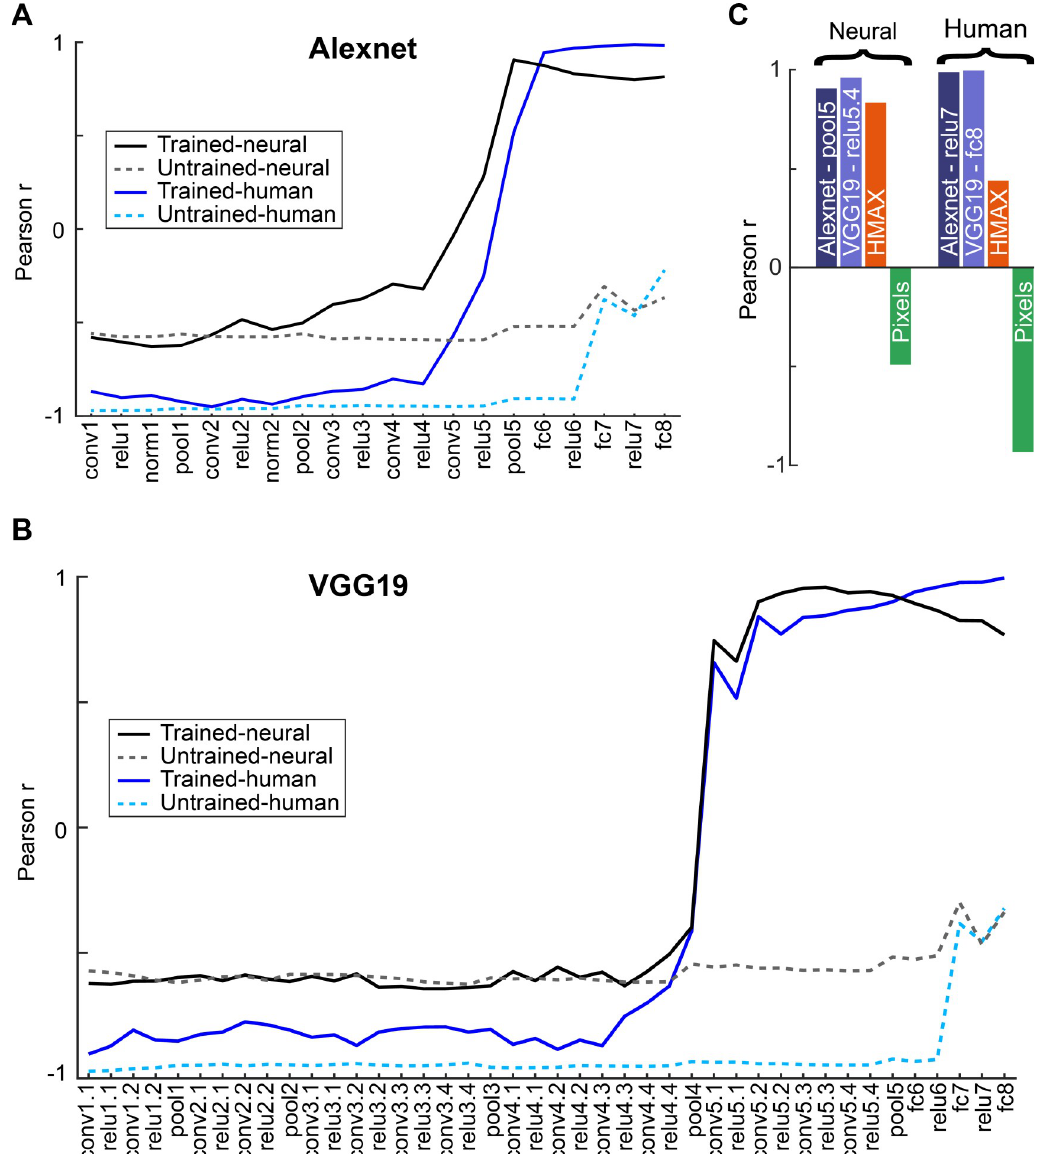
Fig 10. Correspondence between model dissimilarities and biological dissimilarities (IT responses and human judgement- based dissimilarities) for the shape groups. (A, B). Gray curves show the Pearson correlation coefficients between the mean neural distances and the mean distances of the CNN layers (n = 6 mean distances per layer). Blue curves show the Pearson correlation coefficients of the CNN layer distances and the distances based on human judgements. Data for trained and untrained CNNs are plotted with full and dashed lines, respectively. Nomenclature of CNN layers as in Fig 2. Results for all two models (Alexnet and VGG-19) are displayed in the subplots (A, B). (C) Neural: Pearson correlation coefficient between the mean IT distances and the mean distances of the peak Alexnet layer, peak VGG-19 layer, the mean HMAX C2 layer distances, and mean pixel-based distances, across shape groups. Human: Pearson correlation coefficient between the distances based on the human judgements and the peak Alexnet layer, peak VGG-19 layer, HMAX C2 layer and pixel-based